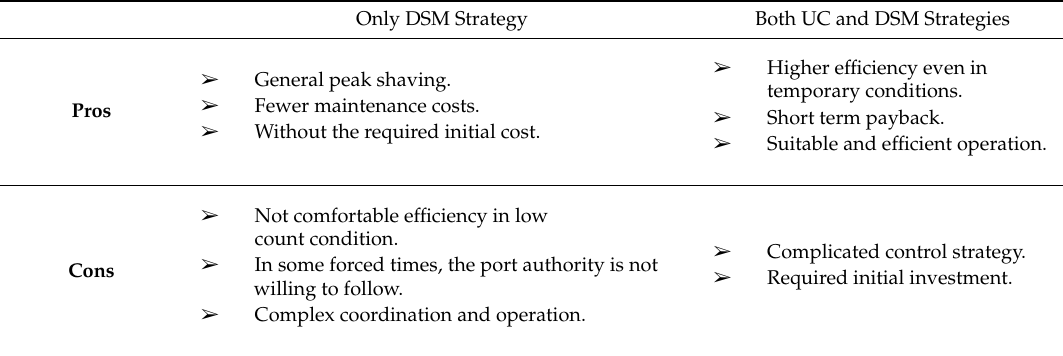
Table 8. Demand-side management (DSM) and UC pros and